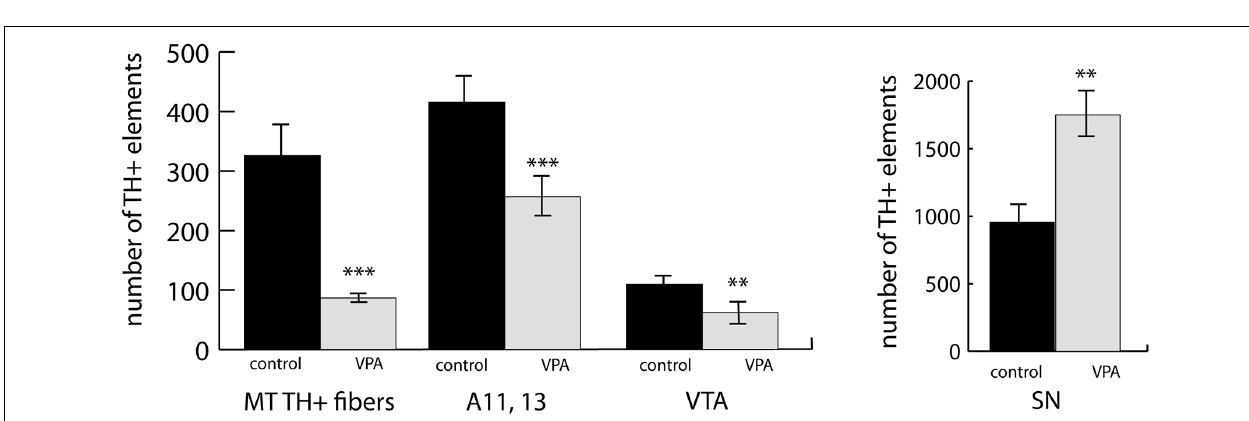
FIGURE 5 | An abundance of fiber bundles (fascicles) of the mesotelencephalic dopaminergic (MT TH+) pathway and neuronal perikarya in the dopaminergic nuclei of the lateral hypothalamus (A11–13), VTA and SN, as revealed by volumetric analysis of TH-immunolabeled whole-mount (iDISCO) brain samples of control and VPA exposed P7 mouse pups. The diagrams represent the mean ± SE, n = 6 (control), n = 6 (VPA); ∗∗ p < 0.01, ∗∗∗ p <